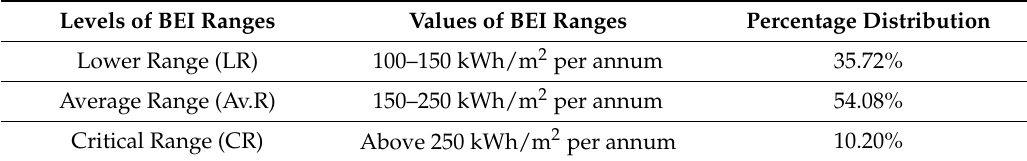
Table 1. Percentage distribution of three ranges of BEIs of the building stock. Levels of BEI Ranges Values of BEI Ranges Percentage Distribution Lower Range (LR) 100–150 kWh/m 2 per annum Average Range (Av.R) Critical Range (CR) Above 250 kWh/m 2 per